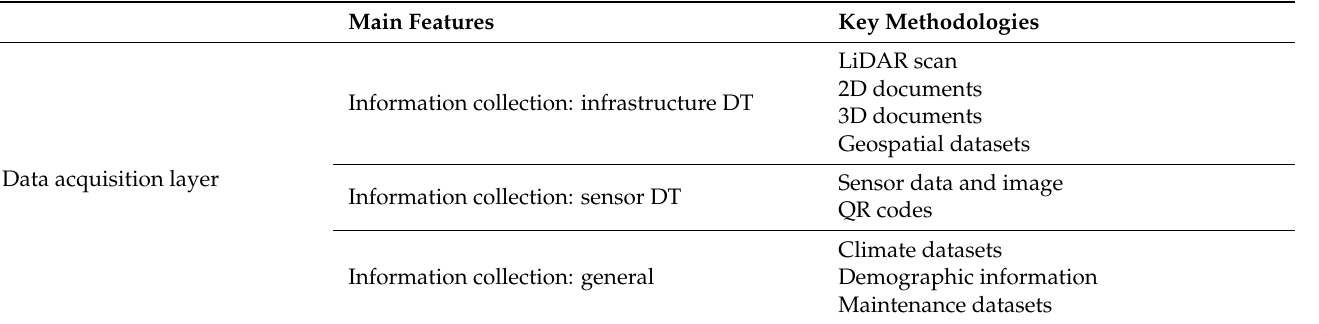
Table 3. Key methodologies for the UTU digital twin.